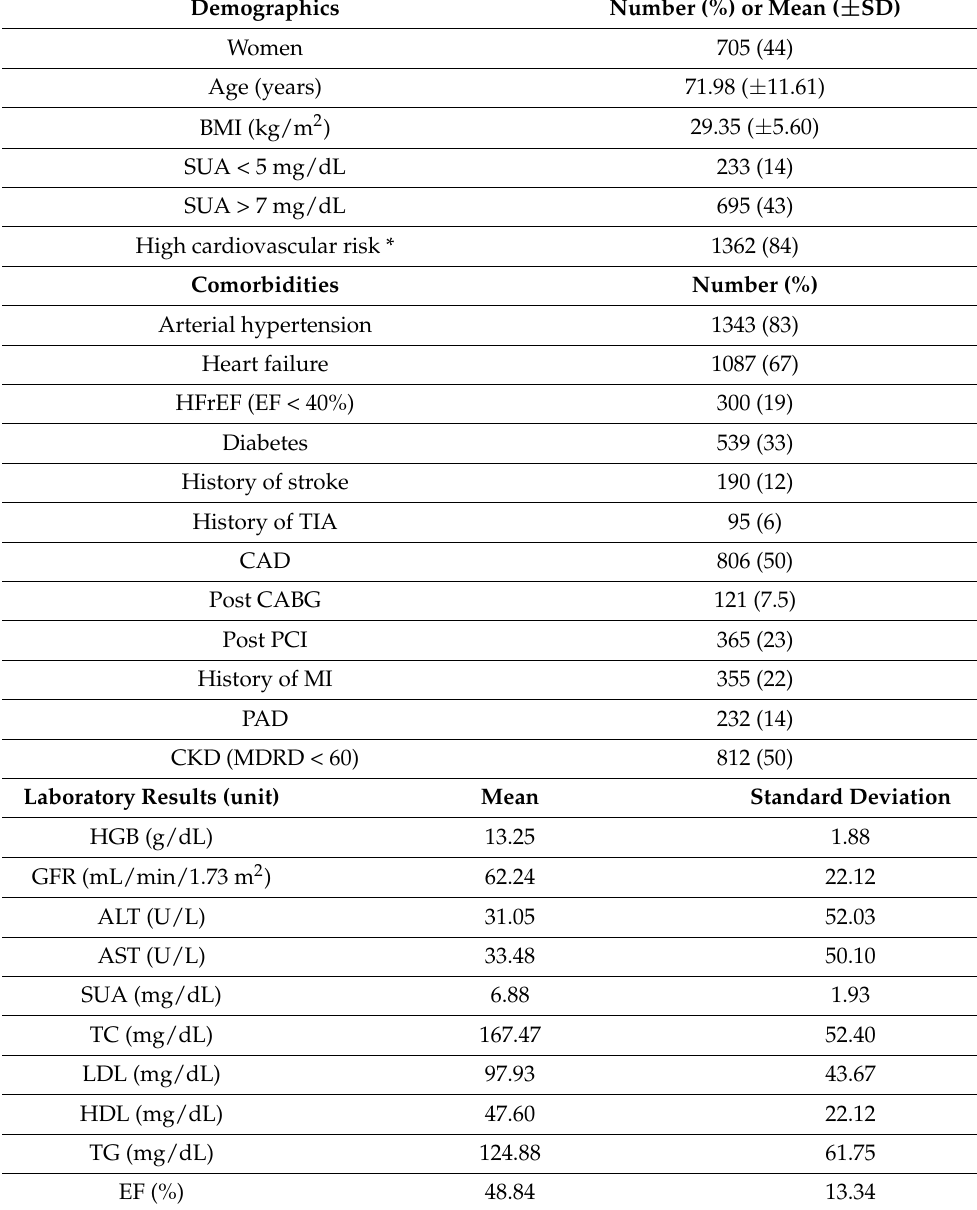
Table 1. General characteristics of study group ( n =